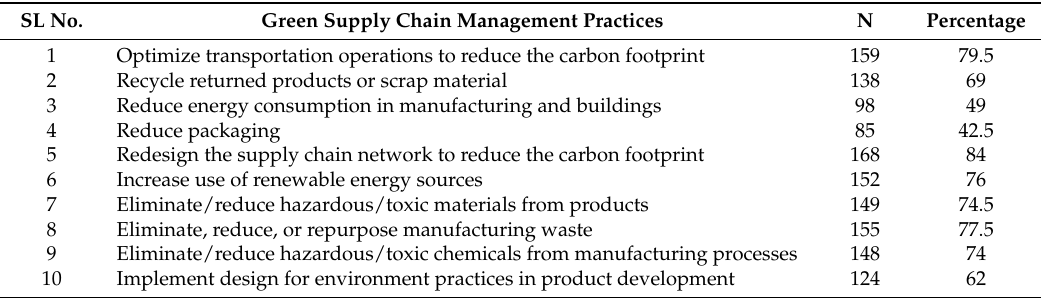
Table 3. Green supply management practices adopted by the textile companies of Gazipur district. SL No.